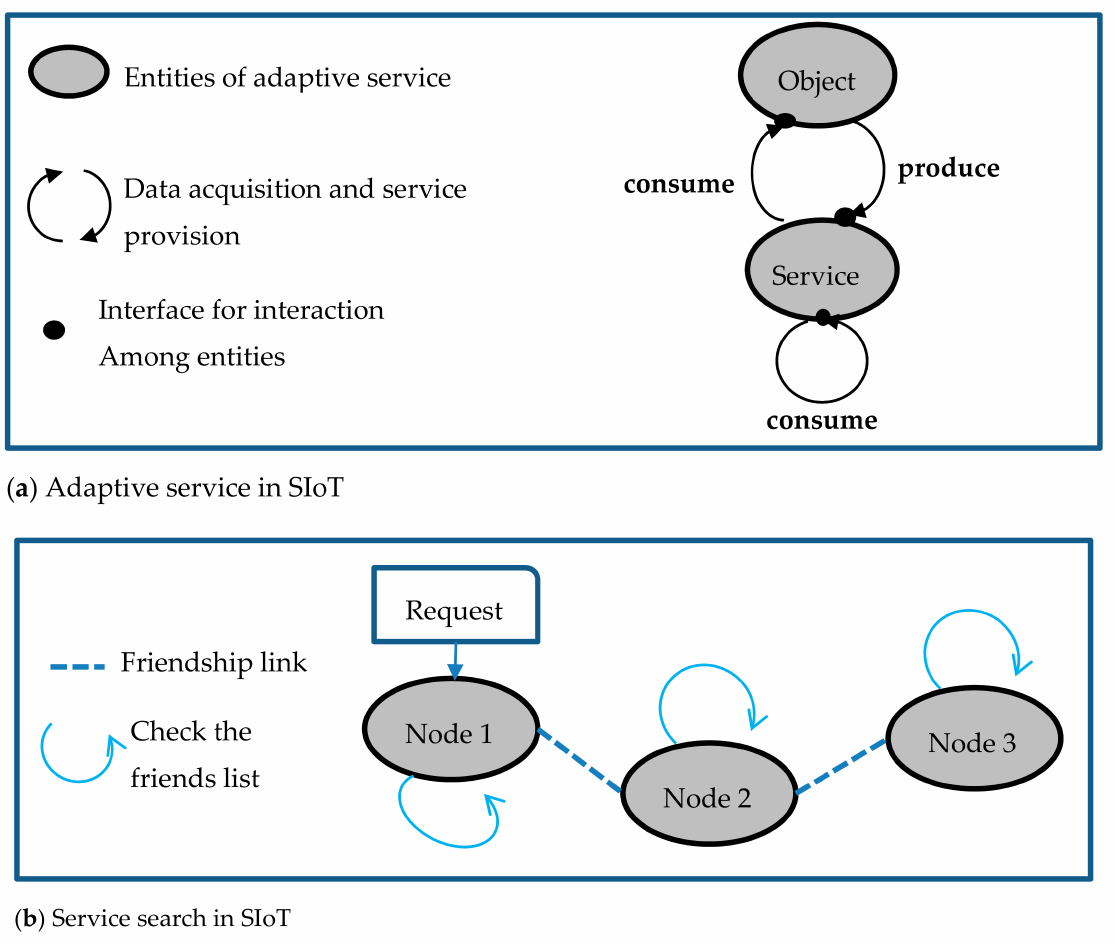
Figure 1. Concept of the social internet of things